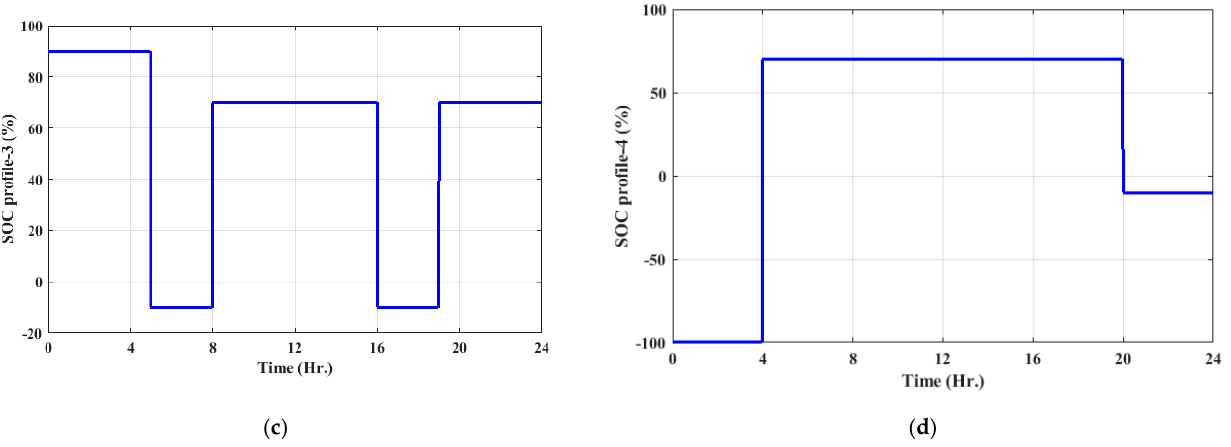
Figure 8. The state of charge of EVs: ( a ) SOC of profile1; ( b ) SOC of profile2; ( c ) SOC of profile3; and ( d ) SOC of profile4.